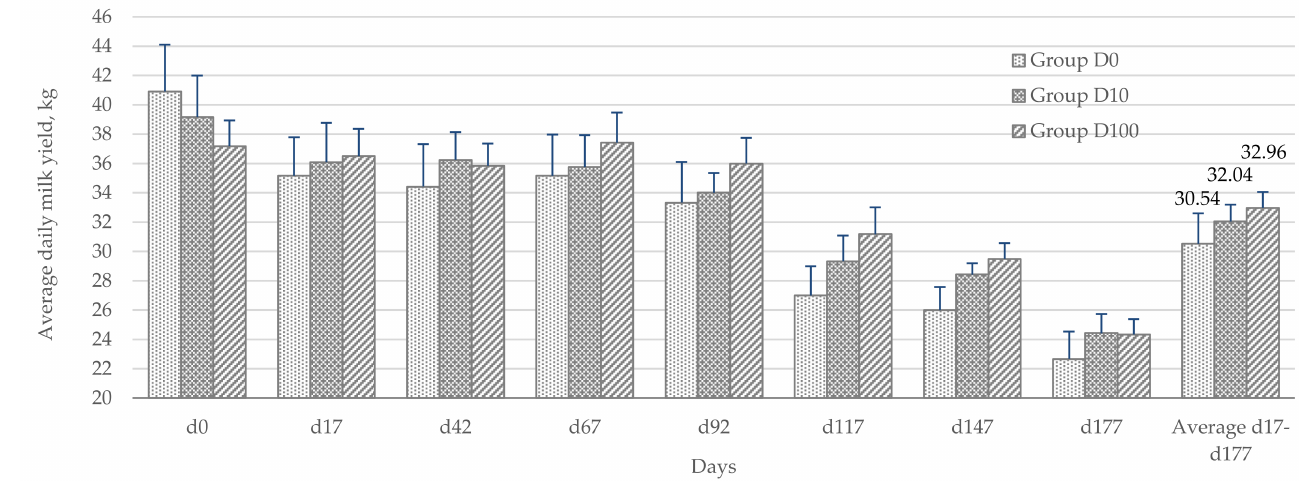
Figure 4. Milk yield of cows (n = 12) of natural fat,